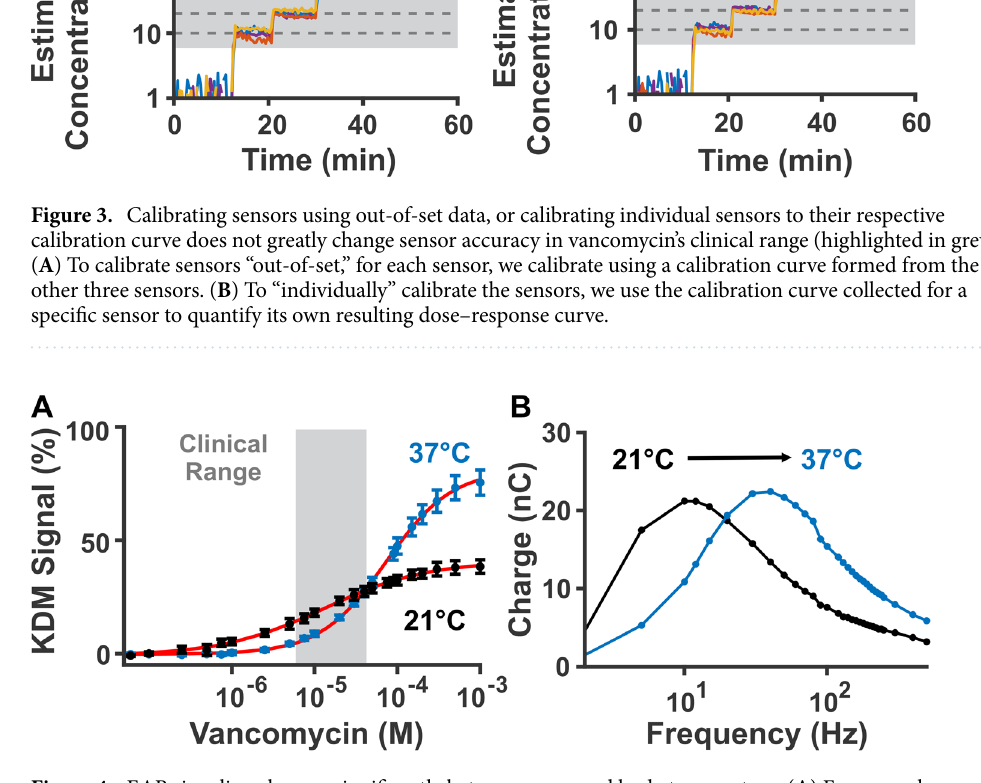
Figure 4. EAB signaling changes significantly between room and body temperature. ( A ) For example, calibration curves measured in freshly collected rat blood at 21 °C (black, n = 4 sensors, K 1/2 = 13 ± 2 µM) and 37 °C (blue, n = 4 sensors, K 1/2 = 73 ± 4 µM) differ in their binding midpoint, Hill coefficient, and signal gain (Table S3). ( B ) This occurs at least in part because the electron transfer rate from the redox reporter changes with temperature. Specifically, the peak charge transfer rate shifts toward higher frequencies at higher temperatures. To illustrate this, we plot here charge transfer versus frequency for a representative sensor